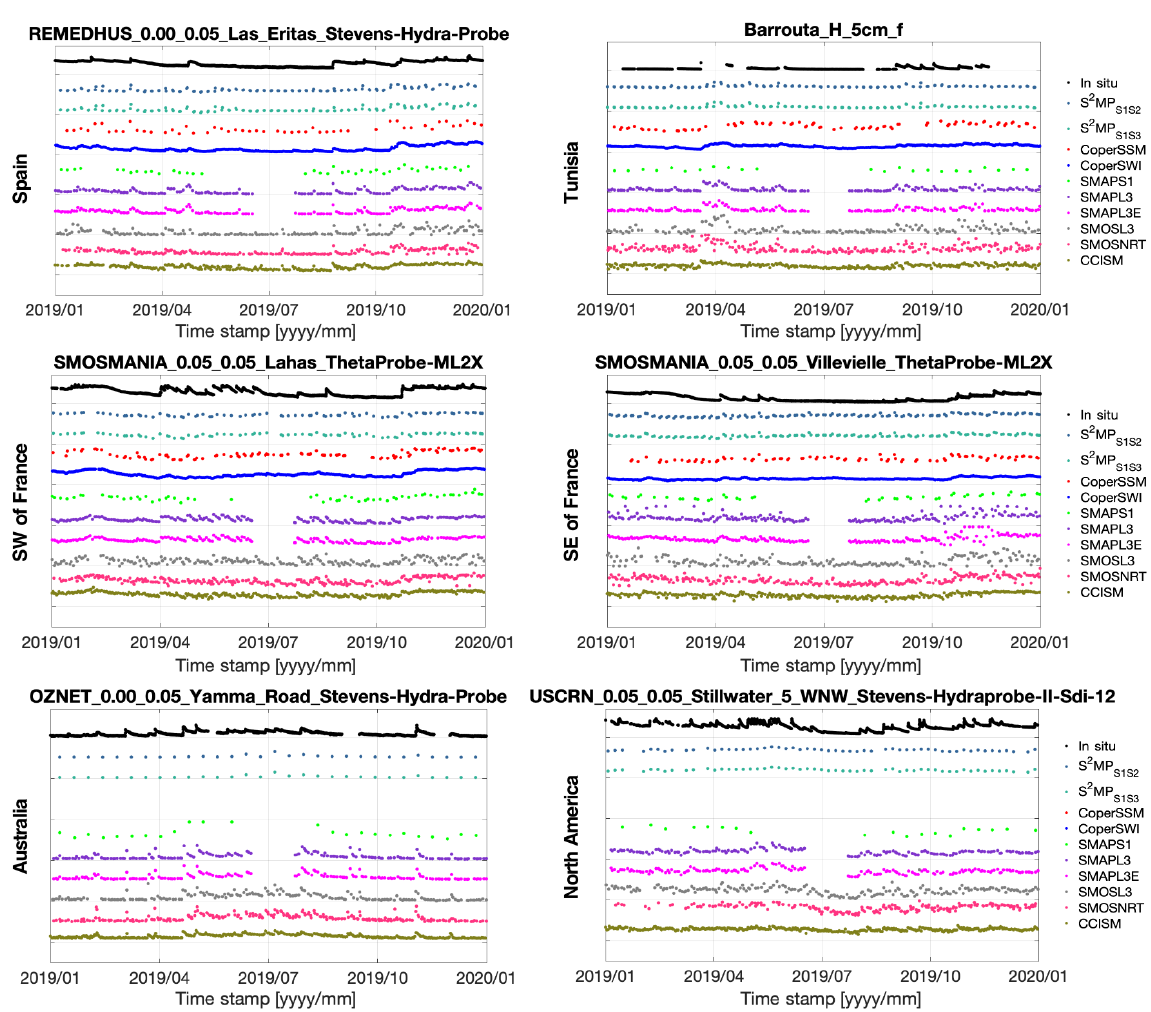
Figure 8. Examples of SM time series from the different HR and CR datasets at six in situ stations (one for each region).